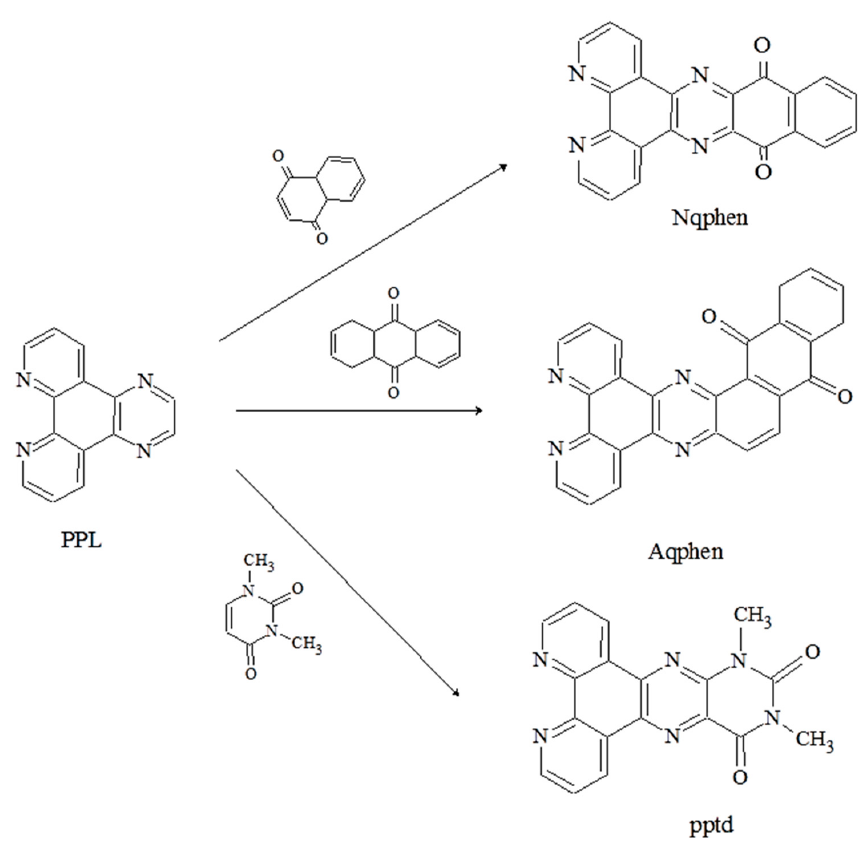
Scheme 1. Decomposition of polypyridinic ligands in term of fragment components.